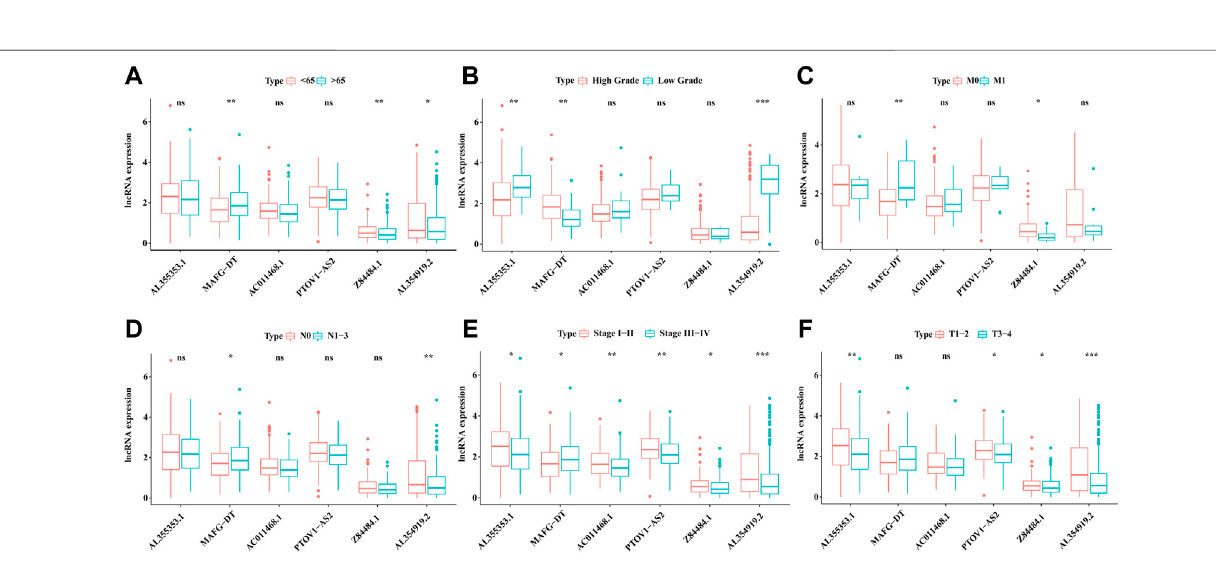
Frontiers in Genetics |